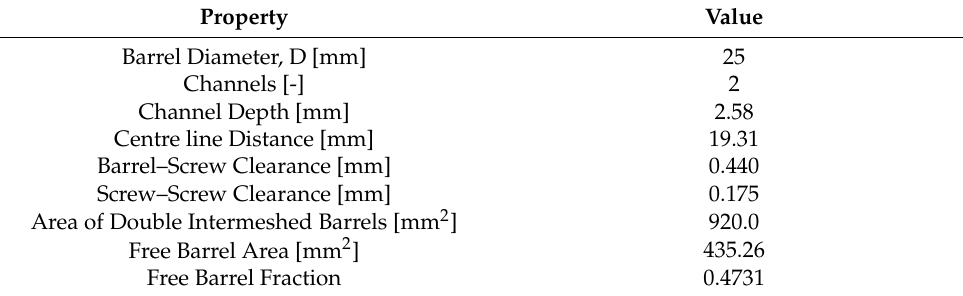
Table 1. Key ConsiGma 1/25 Dimensions.